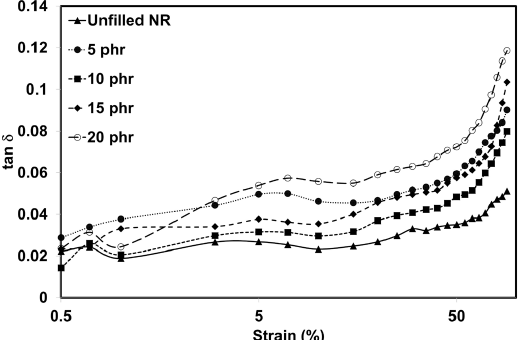
Figure 6. Damping factor or tan δ of unfilled and sepiolite filled NR composites.